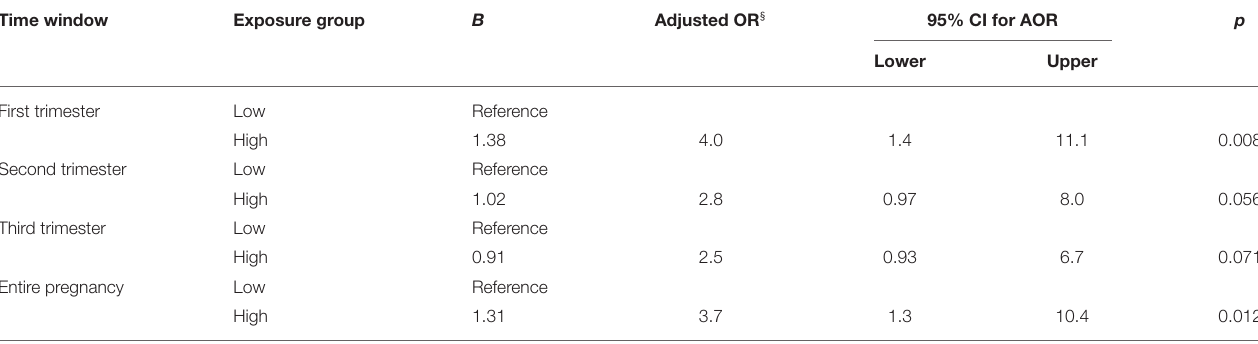
TABLE 3 | Odds ratios (OR) and their 95% Confidence Intervals (CI) for PE in association with high NO x exposure as compared with low NO x exposure (median cut-off).